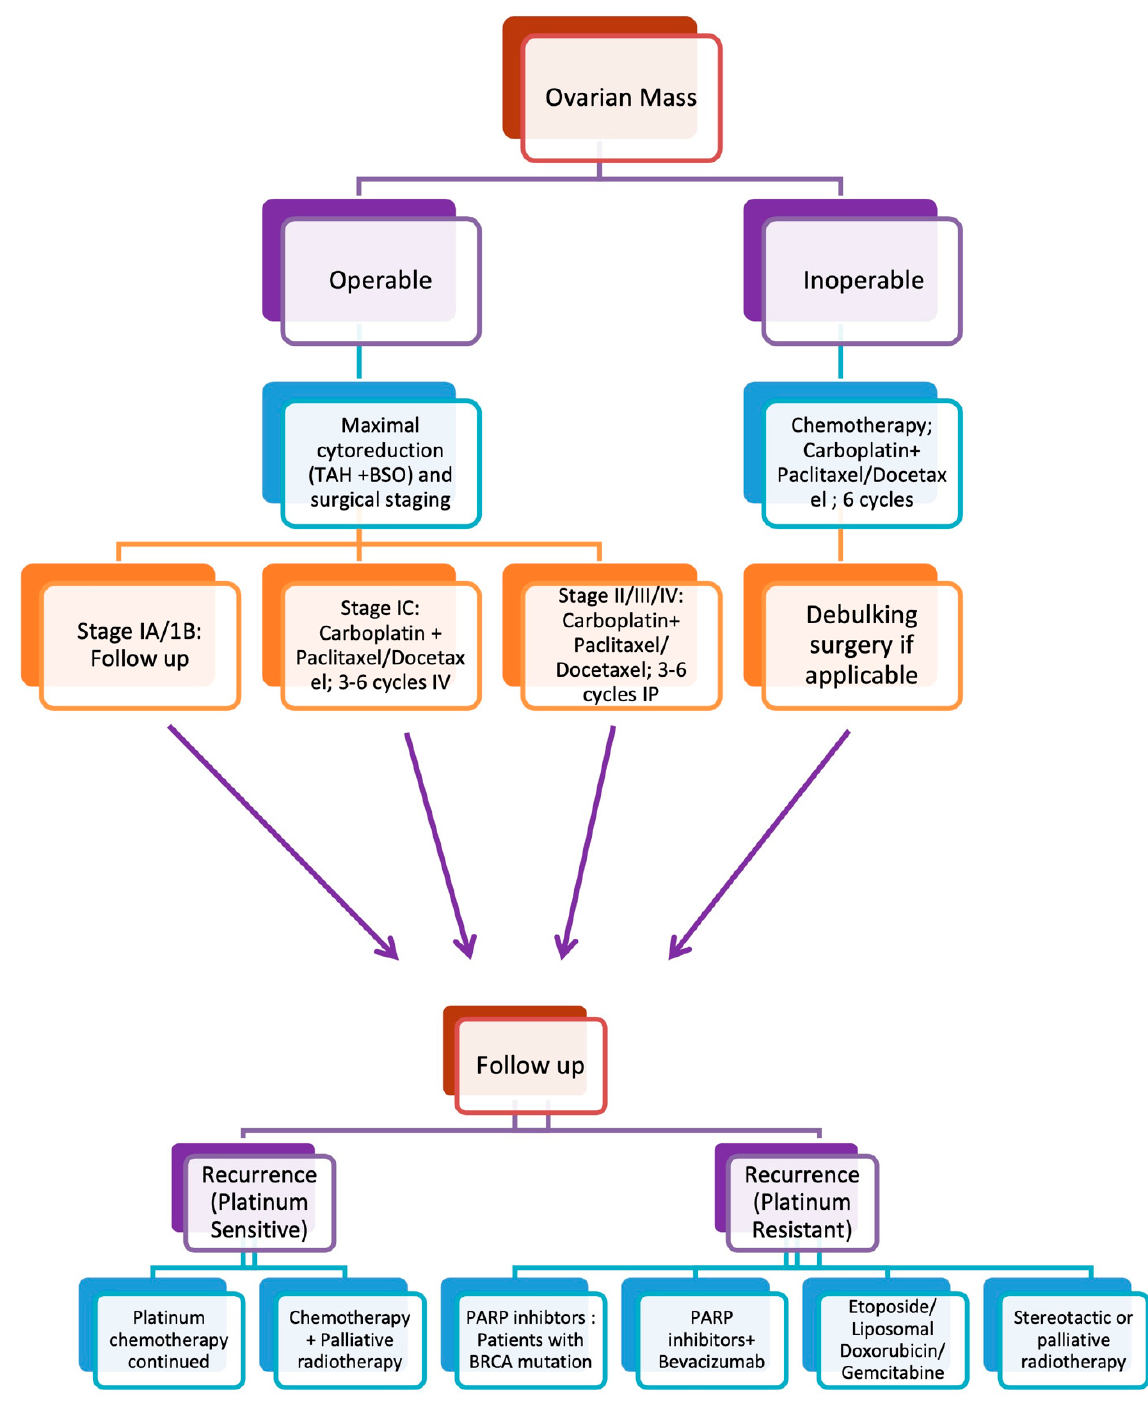
Figure 1. Summary of the widely used treatment strategies for ovarian cancer based on surgical staging and other treatment options in the case of disease recurrence.